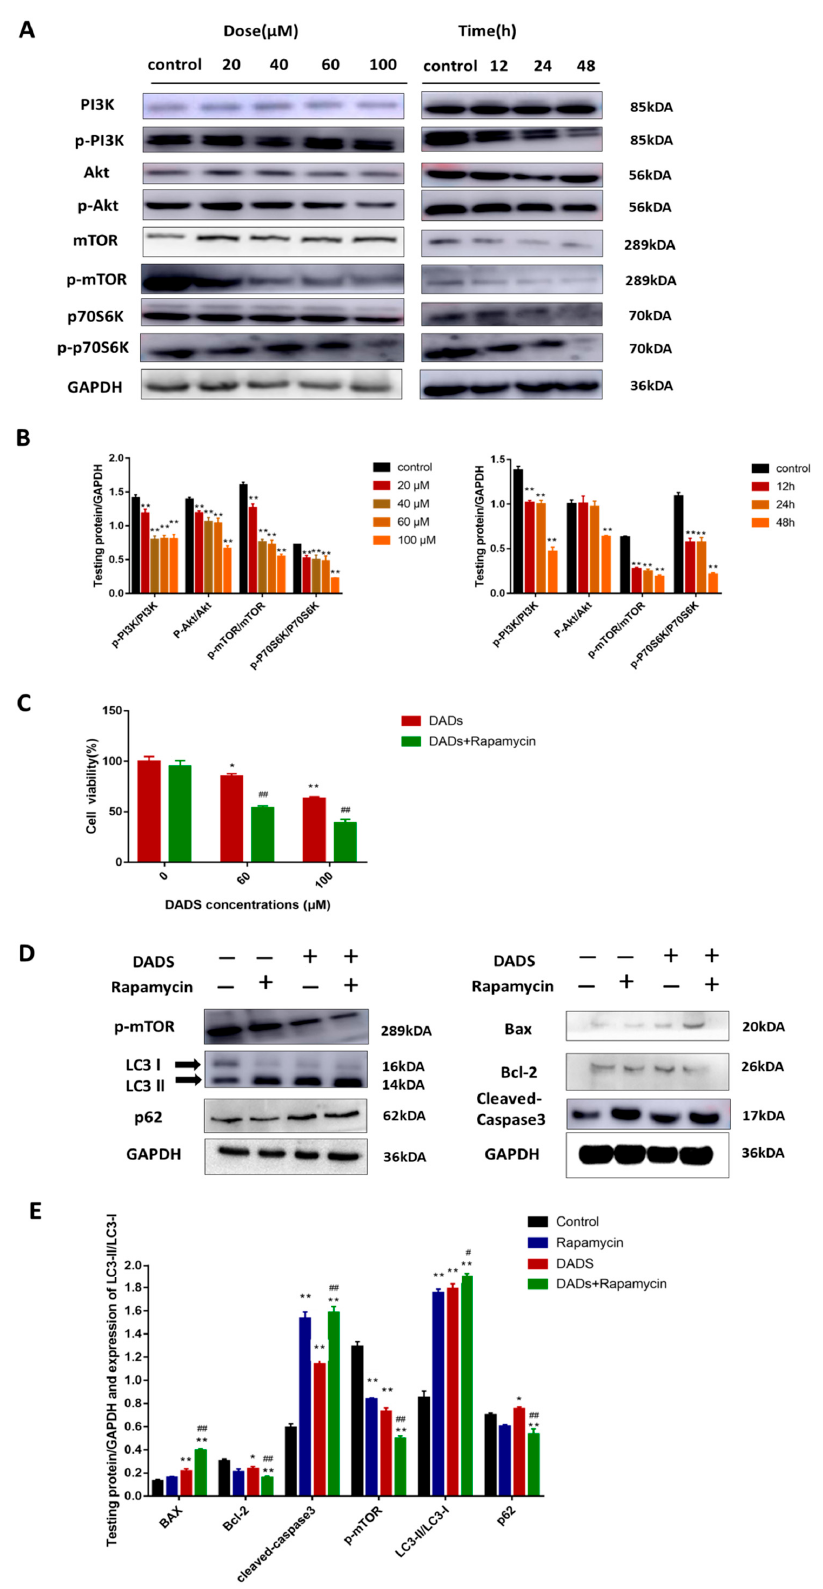
Figure 4. Induced apoptosis and autophagy of OS cells through mTOR pathway. ( A , B ) Expression of PI3K / Akt / mTOR pathway proteins were analyzed by Western blot. Cells were treated with DADs